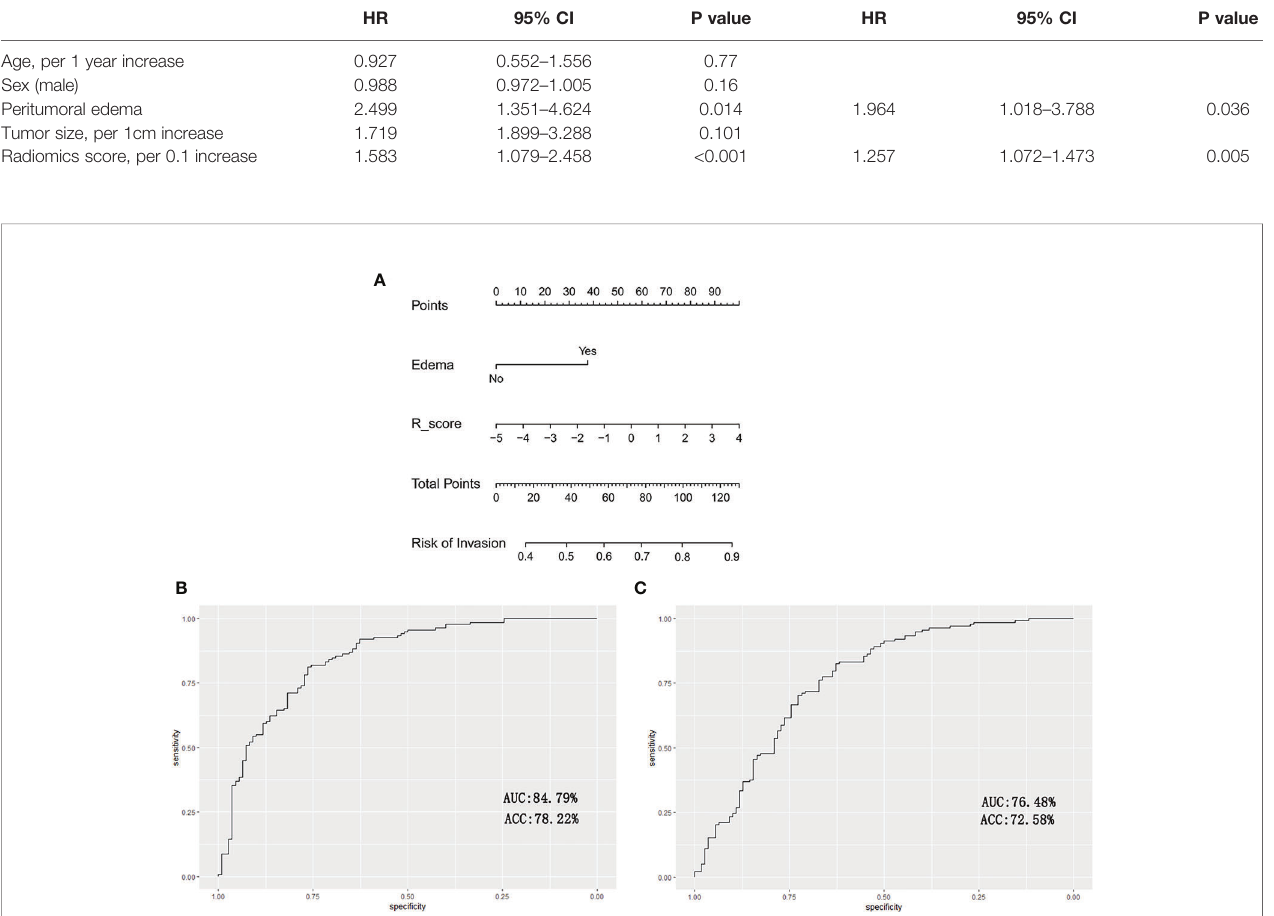
FIGURE 3 | The radiomic-clinical nomogram and its performance are illustrated. (A) The radiomics-clinical nomogram developed to predict the invasiveness of ACPs is illustrated. (B) For the training set, the AUC was 84.79% with the sensitivity, speci fi city and accuracy of 83.27, 76.05, and 78.22%, respectively. (C) For the validation set, the AUC was 76.48% with a sensitivity, speci fi city and accuracy of 71.24, 72.33, and 72.58%,